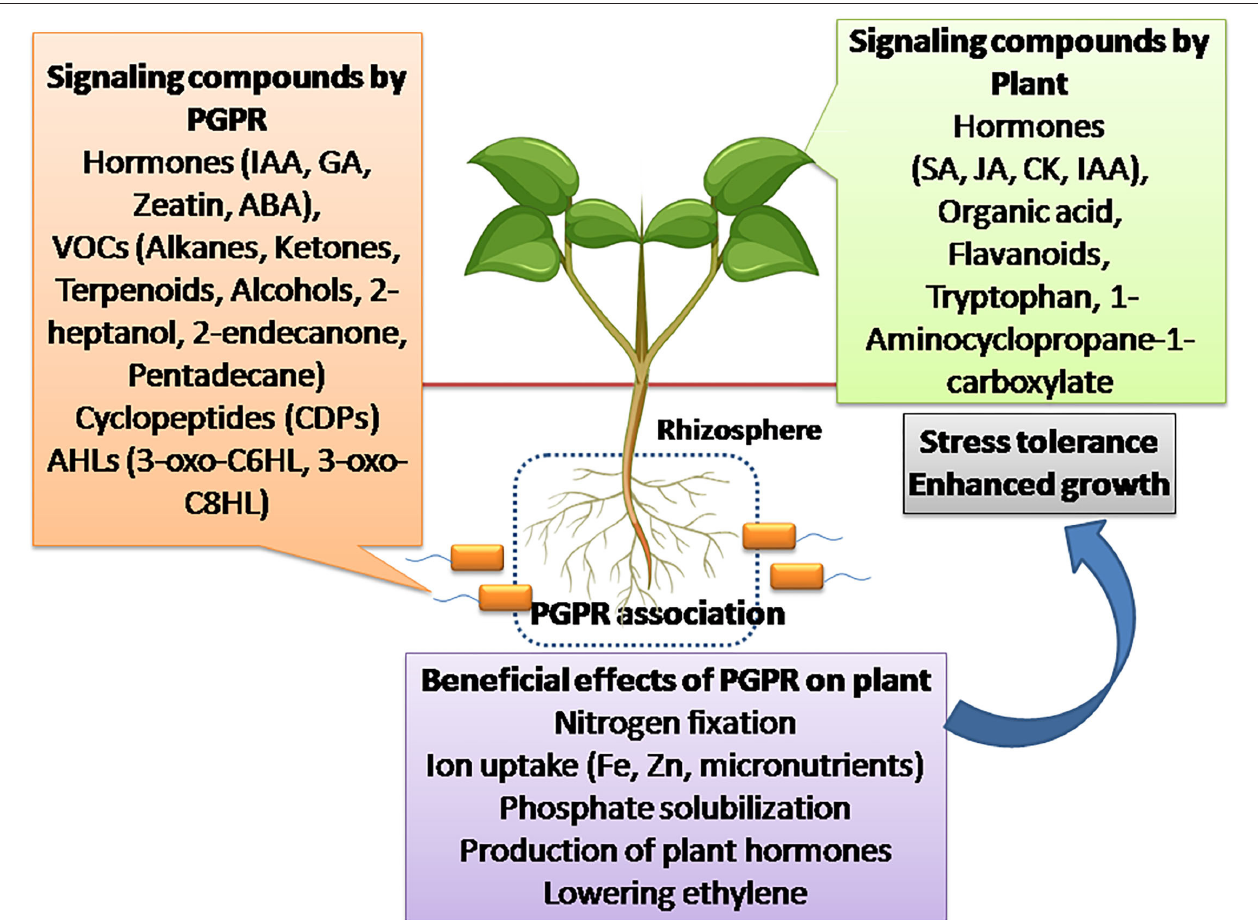
FIGURE 1 | Signaling compounds produced by PGPR and plants for setting up the beneficial rhizospheric association. The compounds produced by PGPR include hormones (IAA, GA, Zeatin, ABA), ACC deaminase, VOCs (Alkanes, Ketones, Terpenoids, Alcohols, 2-heptanol, 2-endecanone, Pentadecane), cyclopeptides (CDPs), acyl homoserine lactones (AHLs) like 3-oxo-C6HL, 3-oxo-C8HL, which triggers plant signaling, helping in plant growth promotion and stress tolerance. Similarly, plants produce signaling molecules like plant growth hormones (SA, JA, CK, IAA) in response to PGPR, helping in their signaling and stress response. The associated PGPR improves plant growth by providing essential minerals through nitrogen fixation, ion uptake (Fe, Zn, micronutrients), and phosphate